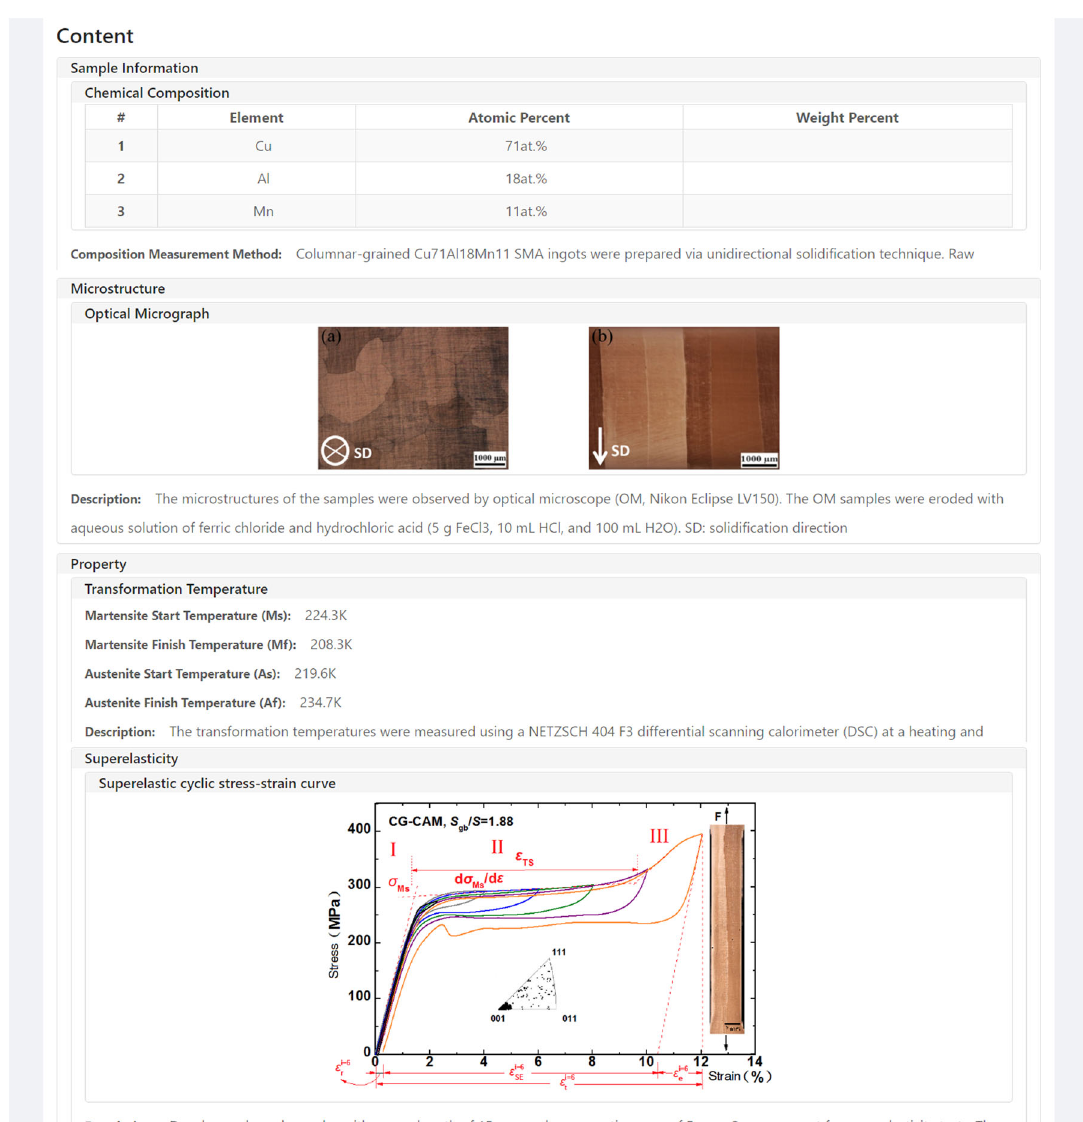
Fig. 4 The data representation interface dynamically generated from a container schema. The data representation interface is generated dynamically according to the schema of the example data of shape memory